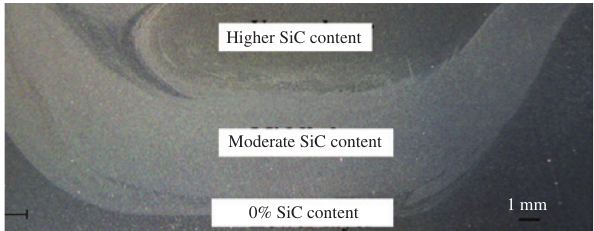
Figure 13: Cross section of Al-SiC FGM prepared by the FSP process [70].